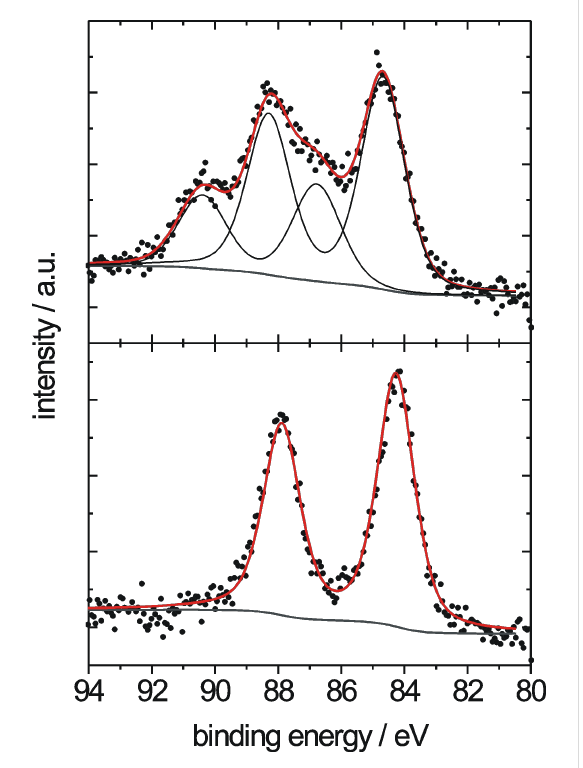
Figure 6: Au(4f) signals of the Au nanoparticles in mesoporous Au/TiO 2 catalyst films before (upper panel) and after (lower panel) oxidative